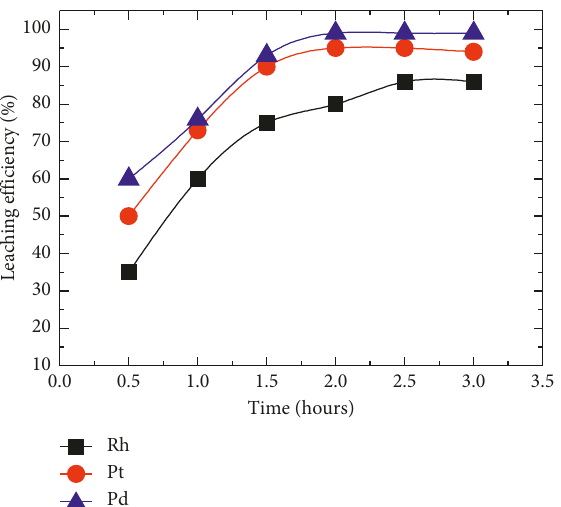
Figure 4: Effect of contact time on the PGM leaching efficiencies using 0.8 vol% H